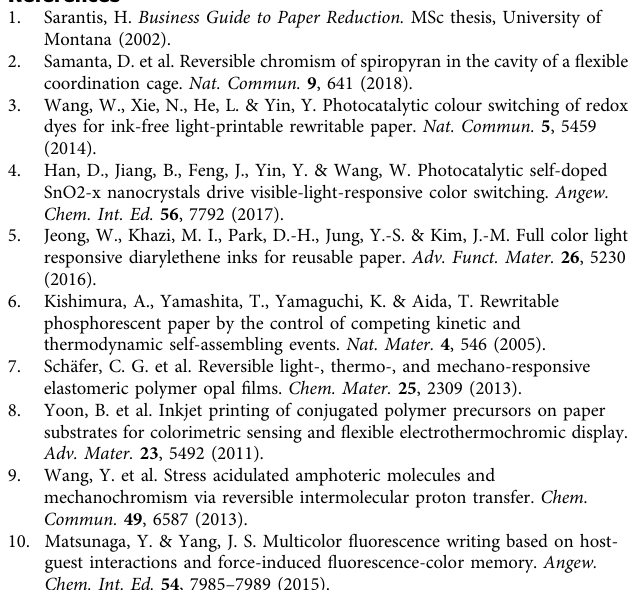
Supplementary Table 1 is from the publically available source: U.S. National Library of Medicine. These data can be obtained free of charge via https://chem.